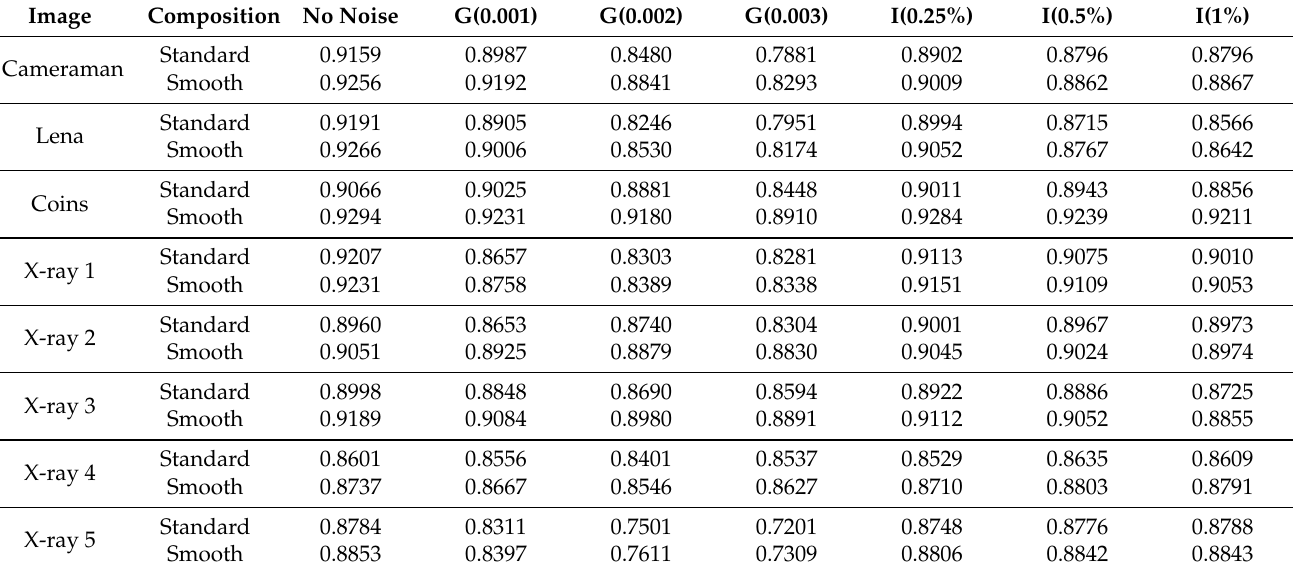
Table 6. PFOM-based comparison of standard composition and smooth composition under different types of